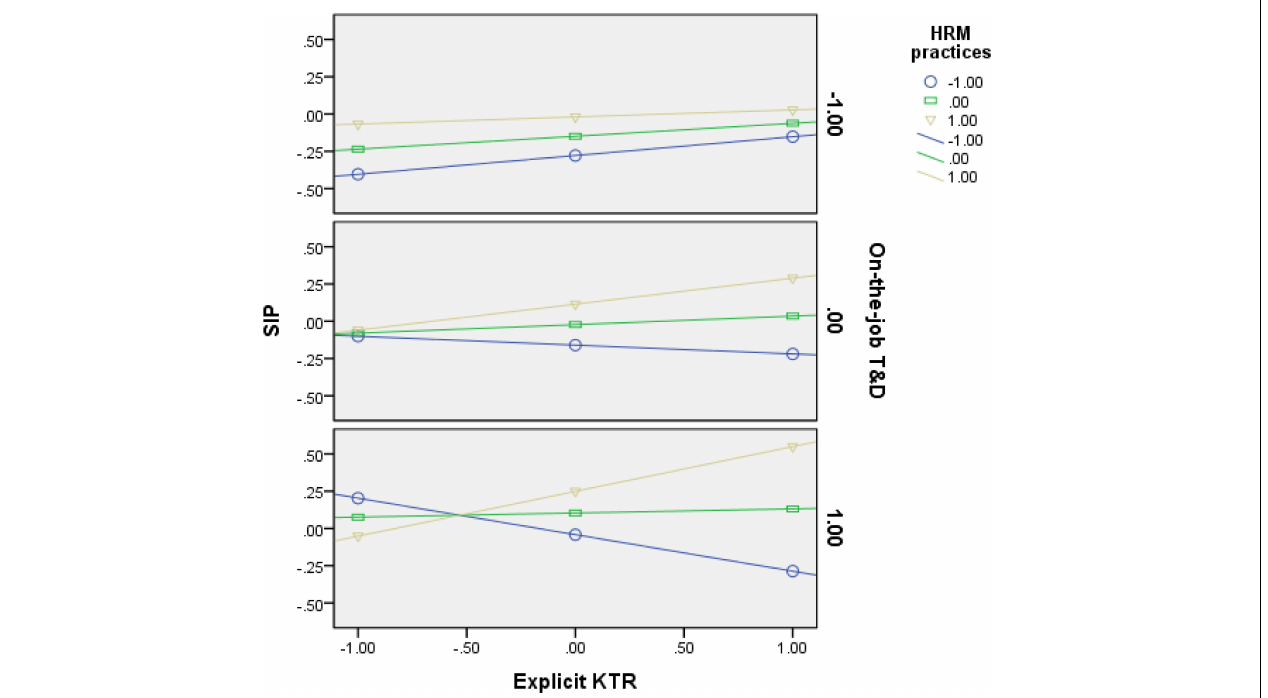
FIGURE 5 | The moderated moderation effects of on-the-job T&D on HRM practices, explicit KTR and SIP.